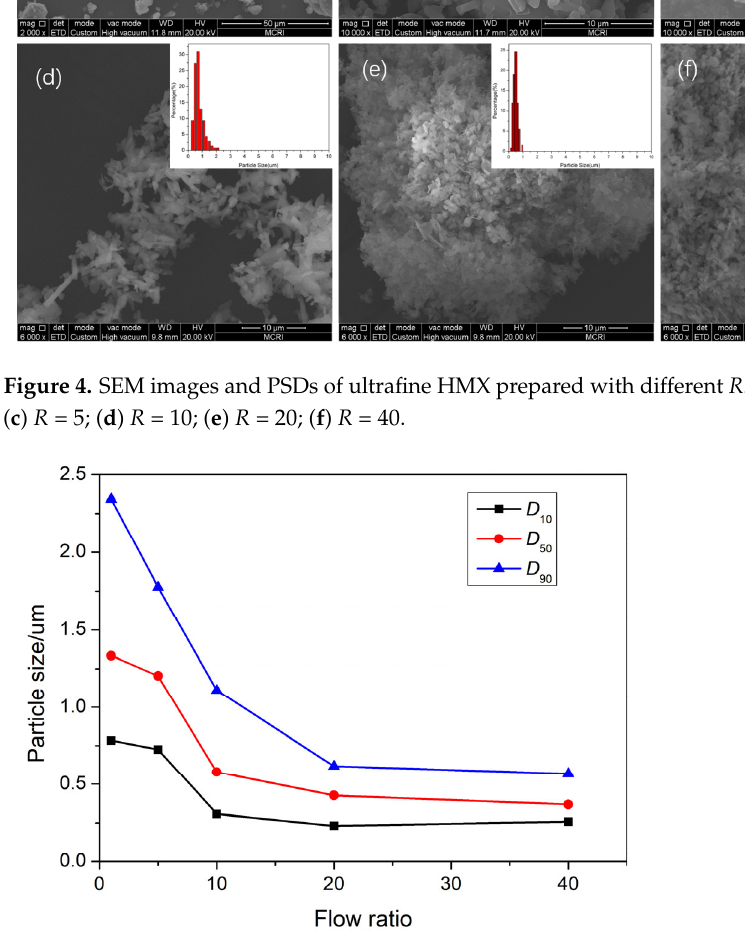
Figure 5. The influence of flow ratio R on particle